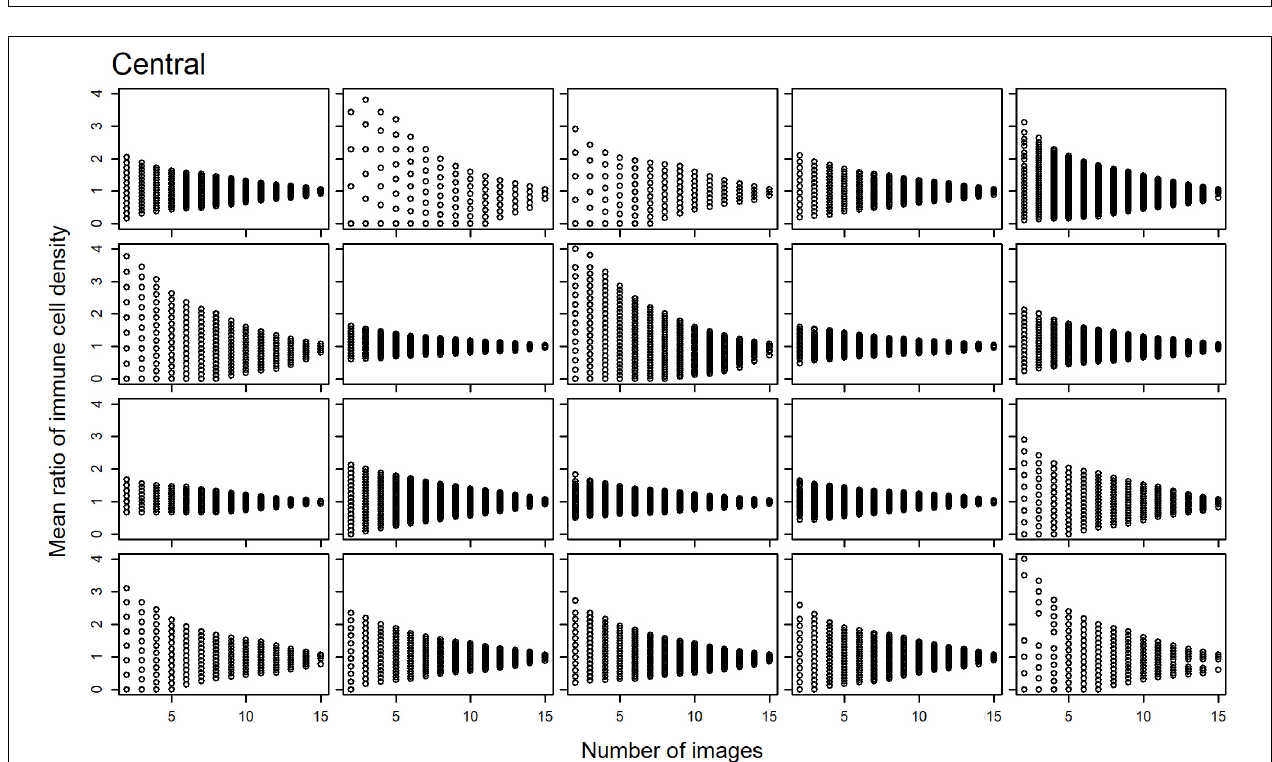
FIGURE 2 | Scatterplots of the mean ratio for corneal epithelial immune cell (IC) density relative to the number of randomly selected, non-overlapping IVCM images used for the density estimate for each participant, in the central